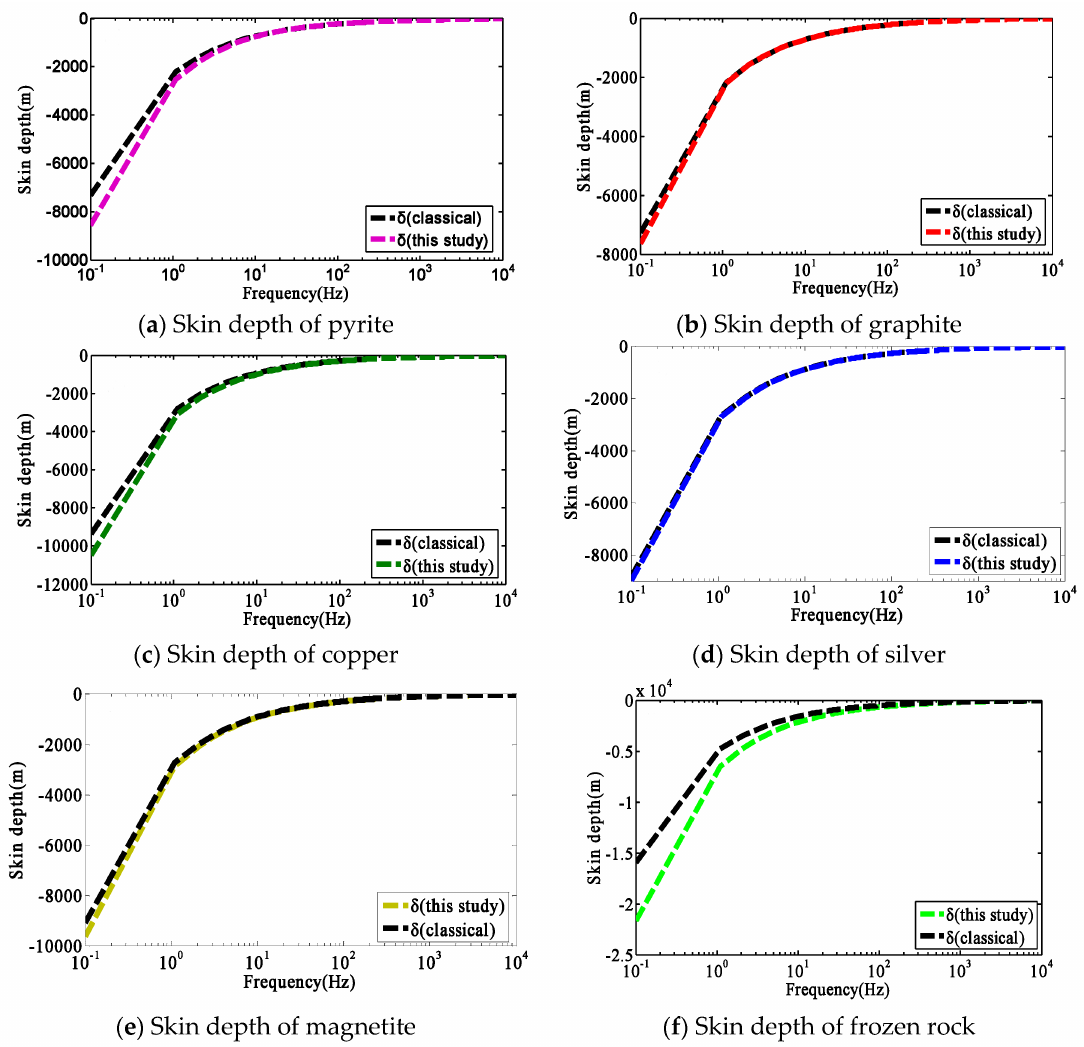
Figure 12. Six models were used to calculate the skin depth (among them, the black curve is the result of the classical skin depth formula and the curve in colour is the result of the generalized skin depth